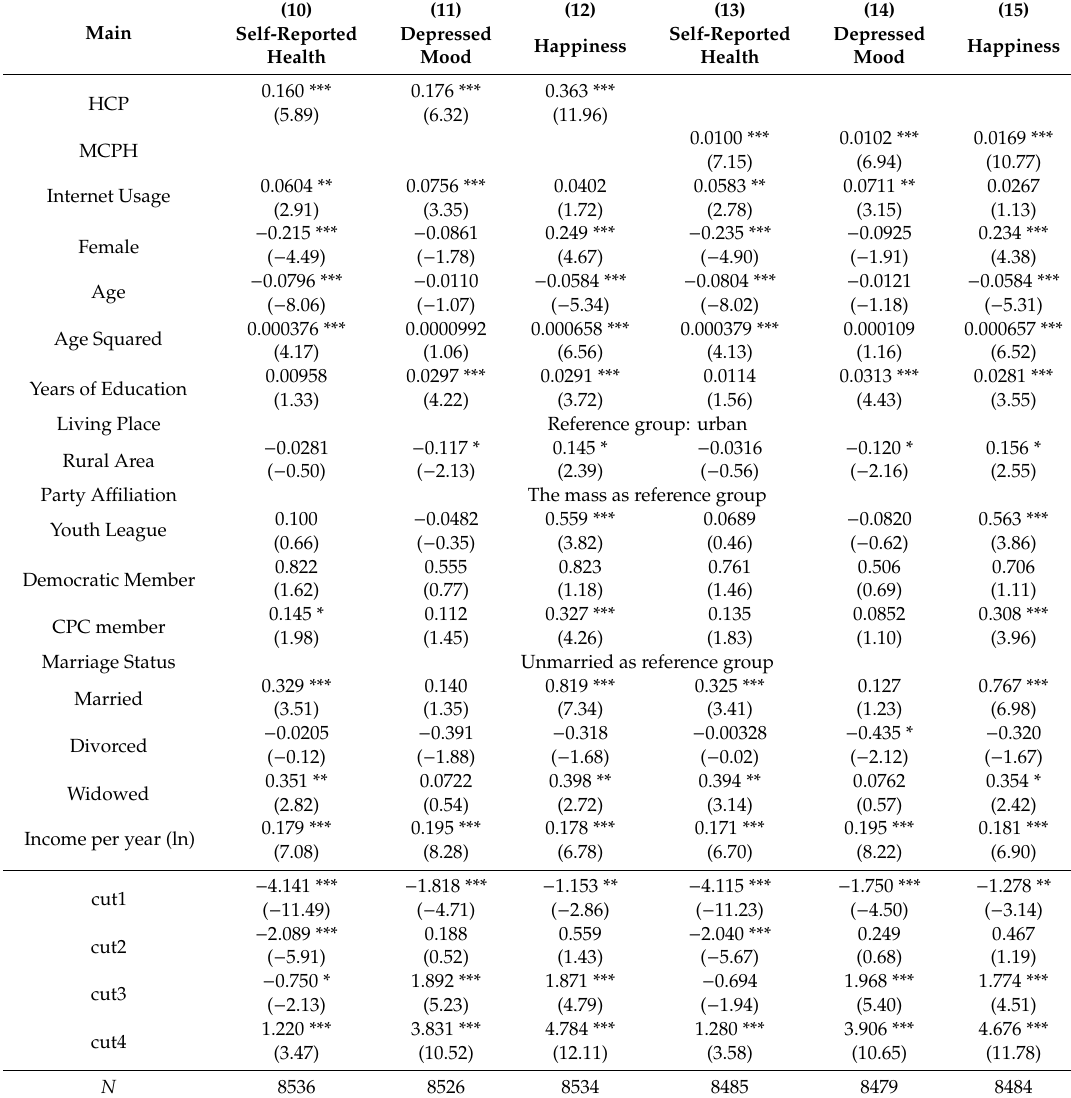
Table 4. Weighted ordered logit model